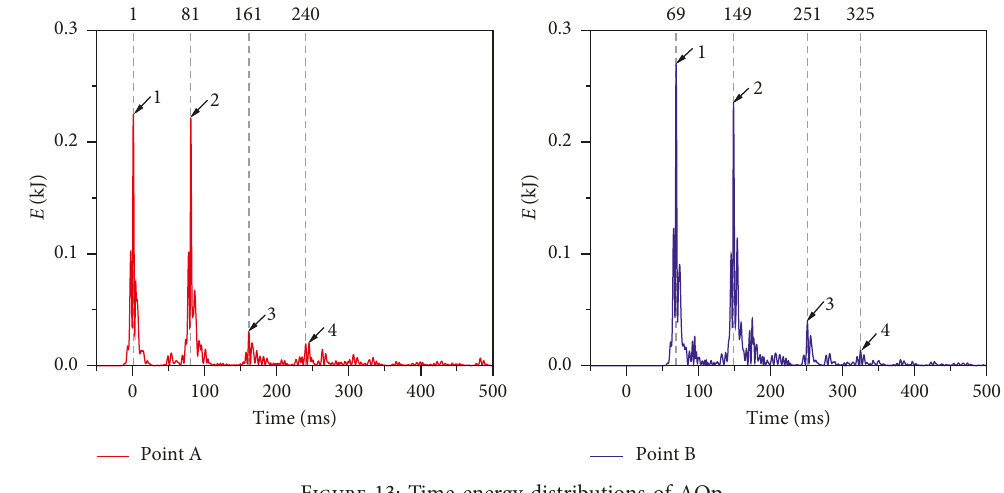
Figure 13: Time-energy distributions of AOp.